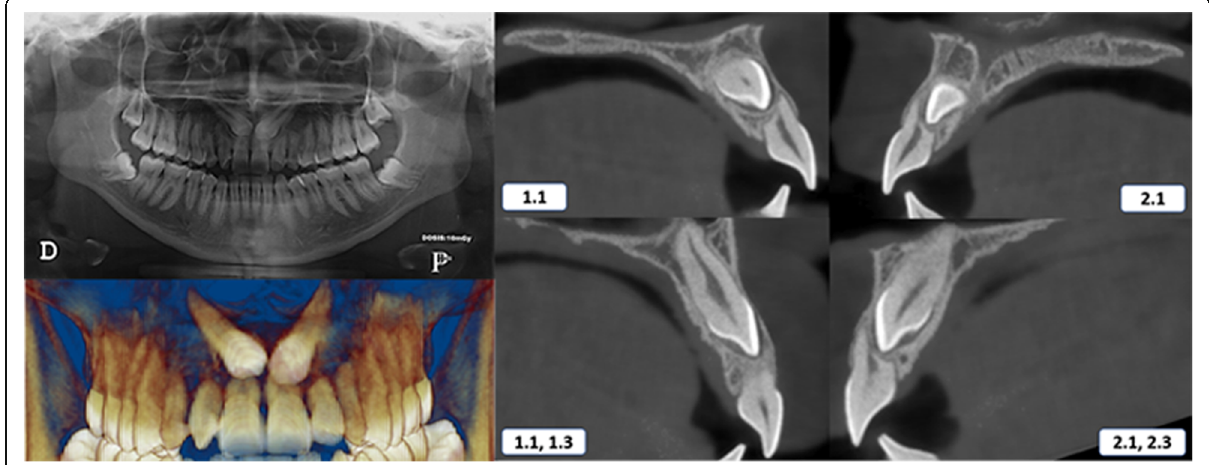
Fig. 1 Initial panoramic radiography and CBCT scans — case 1. 1.1, maxillary right central incisor; 1.3, maxillary right canine; 2.1, maxillary left central incisor; 2.3, maxillary left